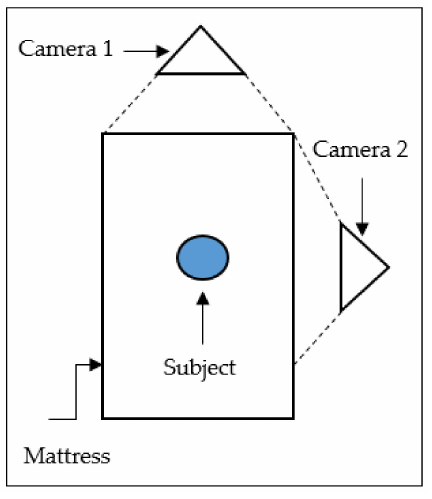
Figure 1. Position of cameras and subject from the top